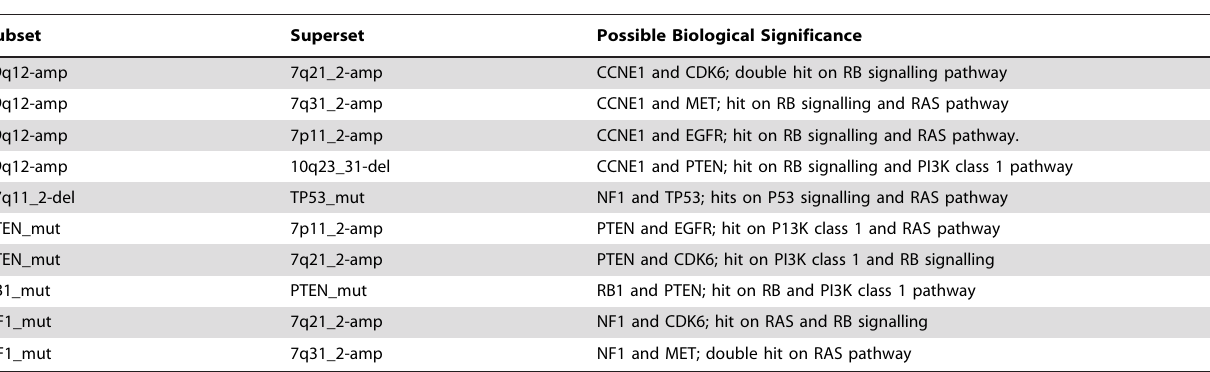
Table 8. Pathway Analysis of HIHI Boolean